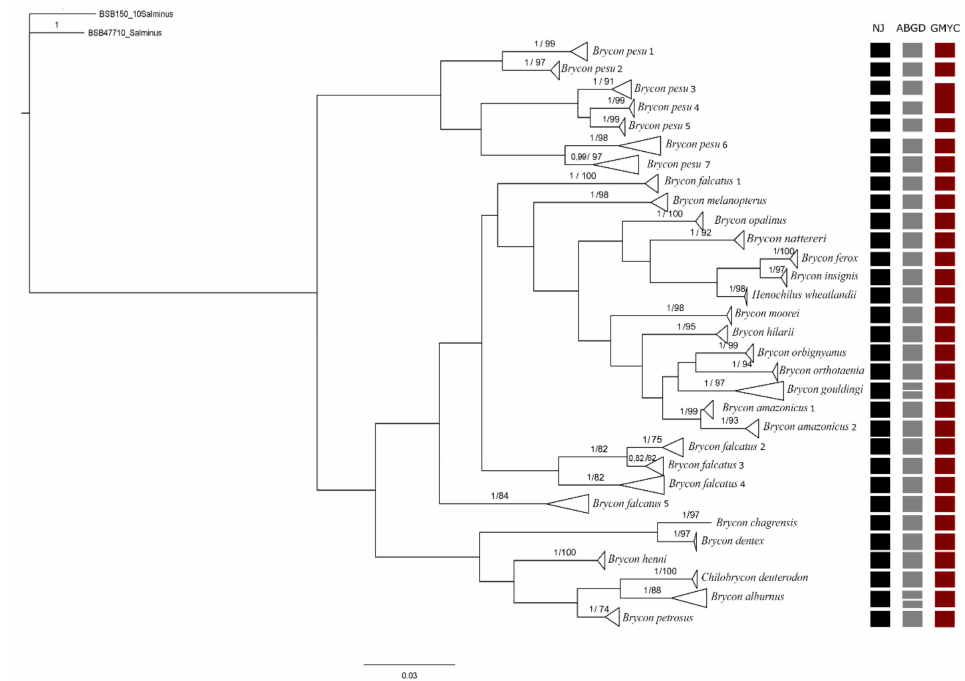
Figure 1. Bayesian Inference topology based on the cytochrome c oxidase I (COI) gene. The bars at the side of the tree represents the results of the analyses of species delimitation. The numbers next to the nodes represent the posterior probability / bootstrap values of the ML